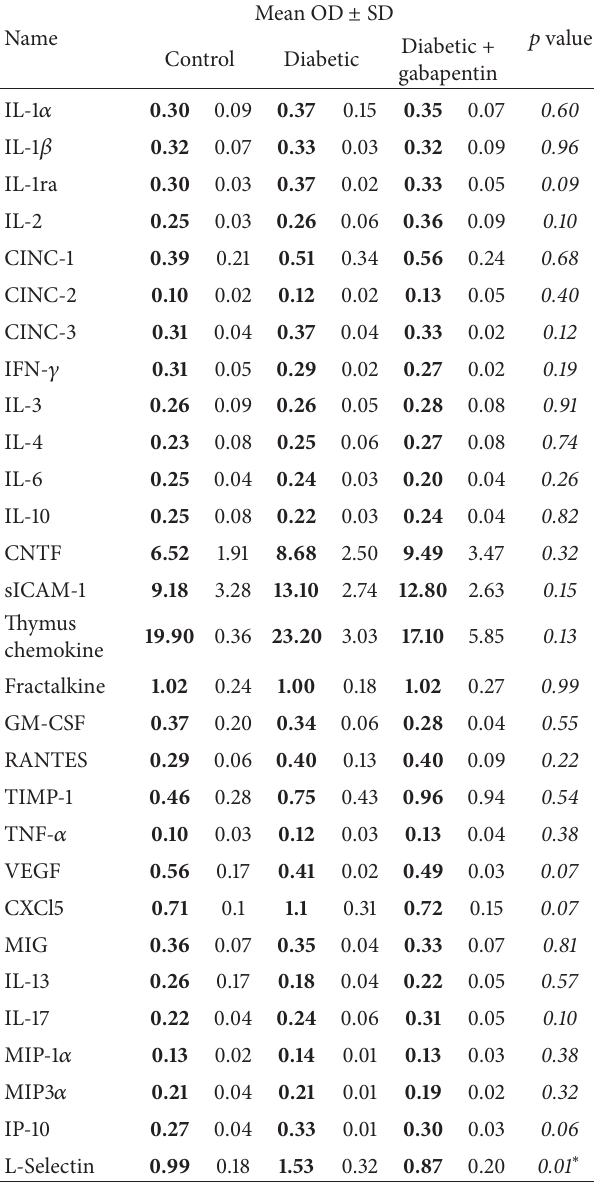
Table 1: Rat spinal cord cytokine proteome array. The levels of 29 cytokines in the lumbar spinal cord of control, diabetic, and gabapentin-treated diabetic rats. Mean values ± SD are displayed. 𝑛 = 4 . ∗ 𝑝 < 0.05 in a 1-way